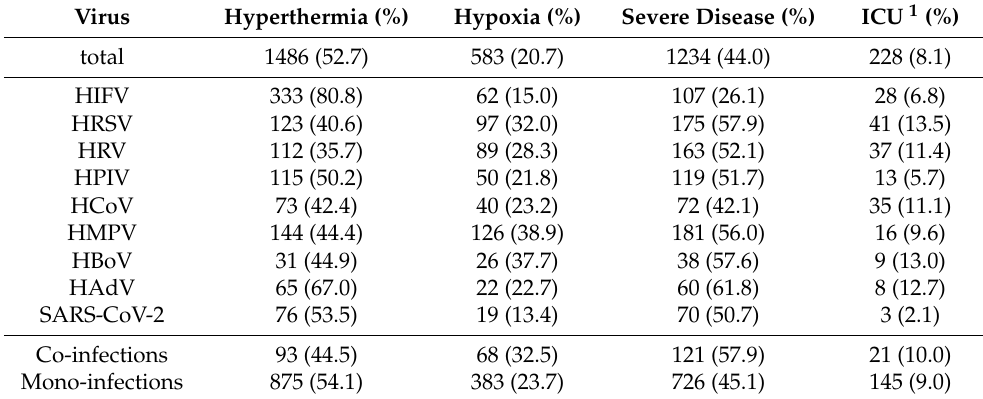
Table 1. Data of disease severity among patients aged 0–17 years hospitalized during